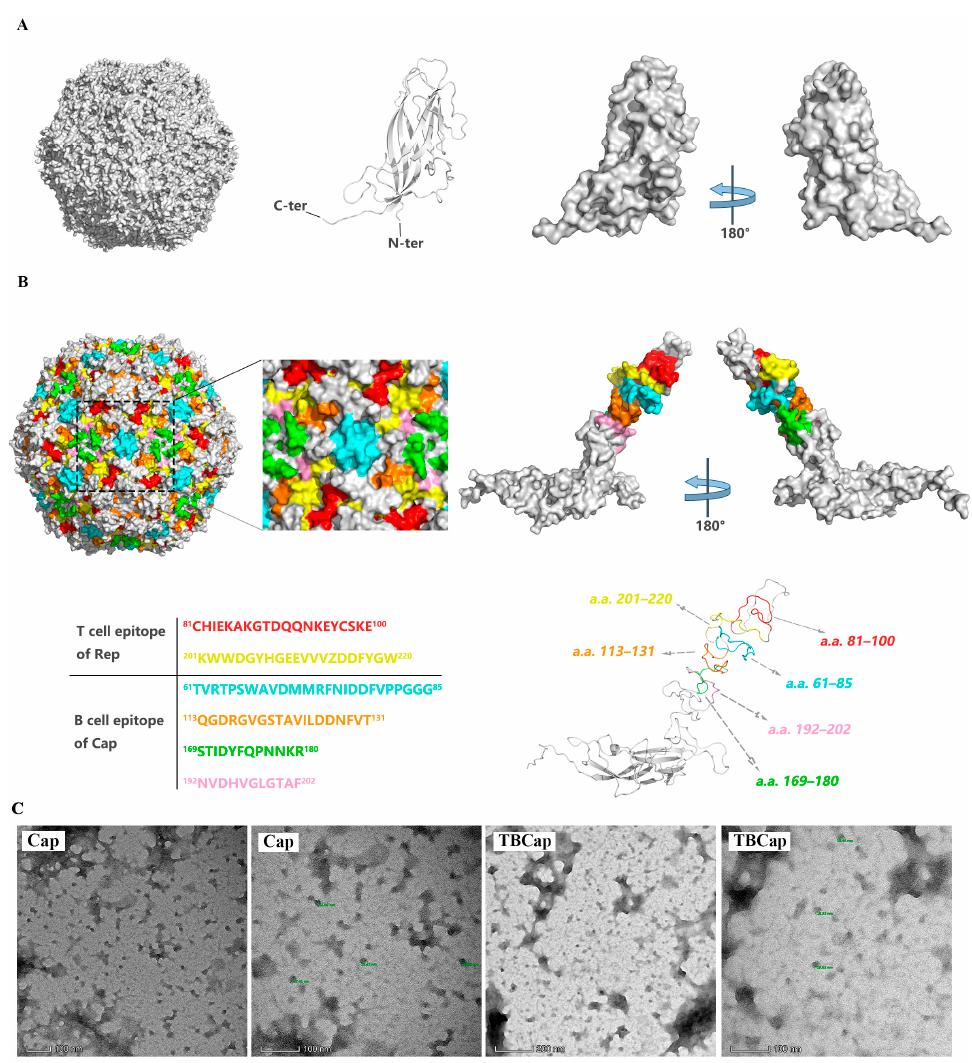
Figure 3. Structural modeling and assembly of PCV2 VLP. ( A ) Three-dimensional reconstruction of the cryo-EM structure of the VLP assembled with the PCV2 cap as the basic unit. Cryo-EM density maps of full-length PCV2 VLPs are shown, with PCV2 VLP density indicated in grey. ( B ) Three- dimensional reconstruction of the cryo-EM structure of the VLP assembled with the TBCap as the basic unit. Again, showing typical icosahedral particle folds, antigenic epitopes on the surface of the PCV2 capsid are shown in different colors and an enlarged region of this capsid is shown. ( C ) The recombinant Cap and TBCap virus-like particles were identified by transmission electron microscopy. VLPs with diameters of approximately 17 nm and 20 nm, respectively, could be observed, consistent with the theoretical size.